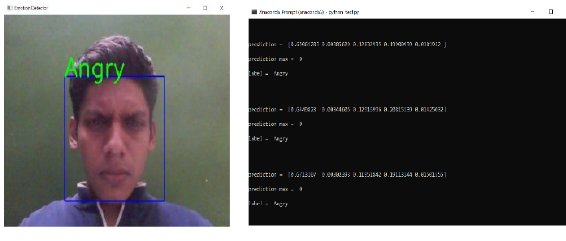
Fig 7. Prediction of Surprise Emotion